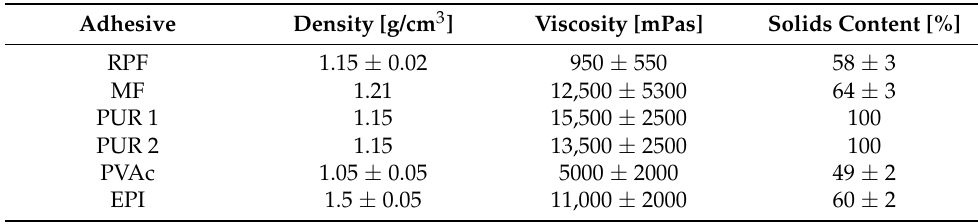
Table 3. Main physical properties of the used adhesives provided in the technical data sheets, according to the adhesive manufacturers.